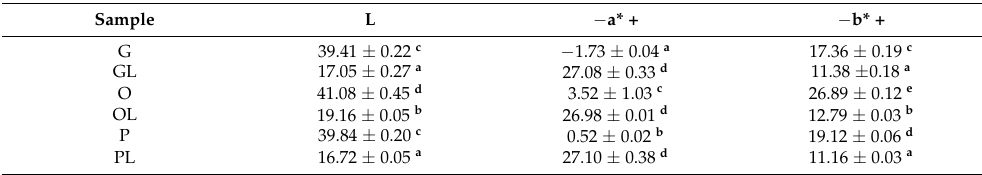
Table 1. Color parameters L, a*, and b* in three types of native oils and oils with lycopene. Letters ( a – e ) represent significant differences between